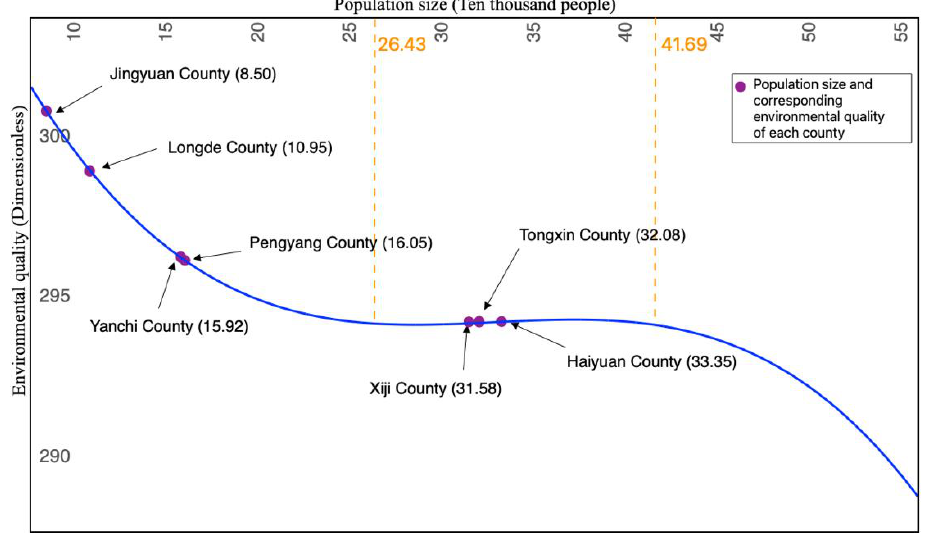
Figure 3. Analysis chart of the population-size and environment-quality model, as well as the current situation. The data in brackets indicate the population of each county in the seventh National Population Census of China (2020). Table 4. Population-size and environmental-quality model estimation results. Variable